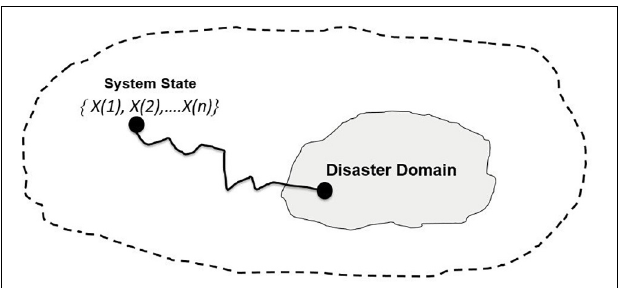
FIGURE 1 | Diagram showing the downward counterfactual search from a historical system